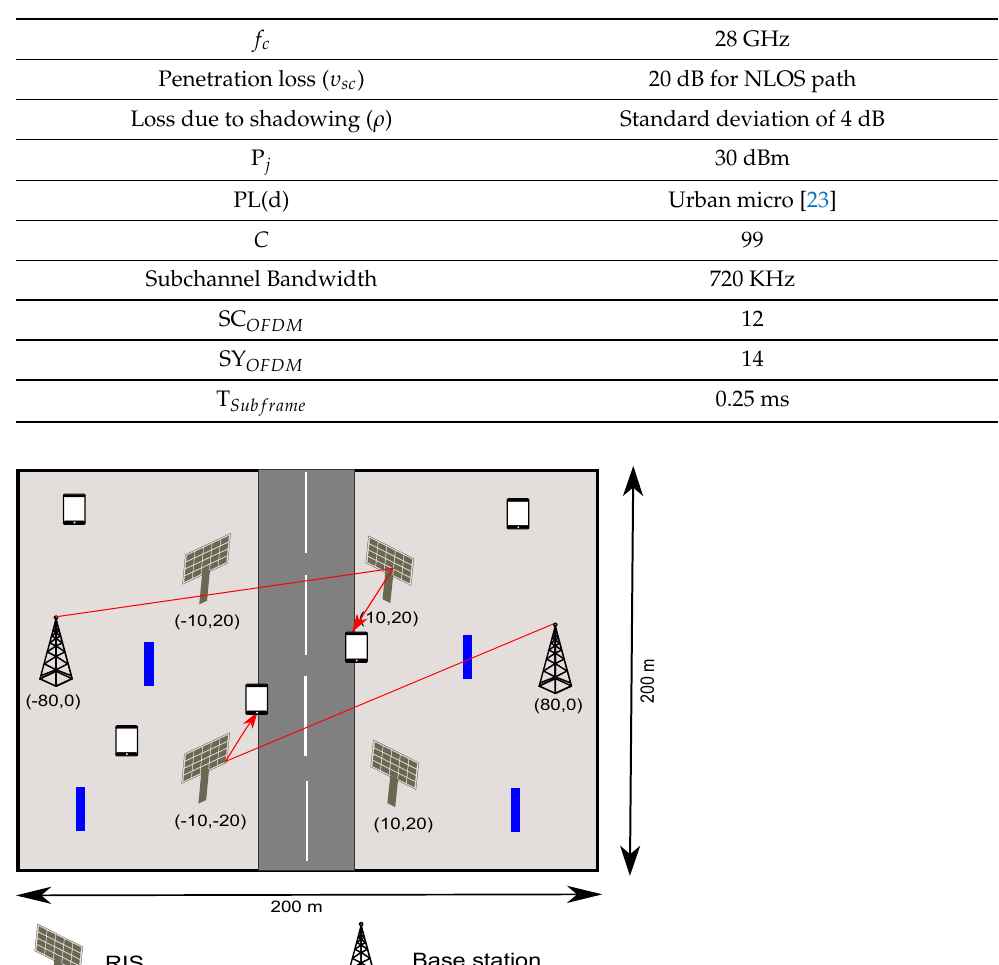
Table 2. Simulation Parameters.